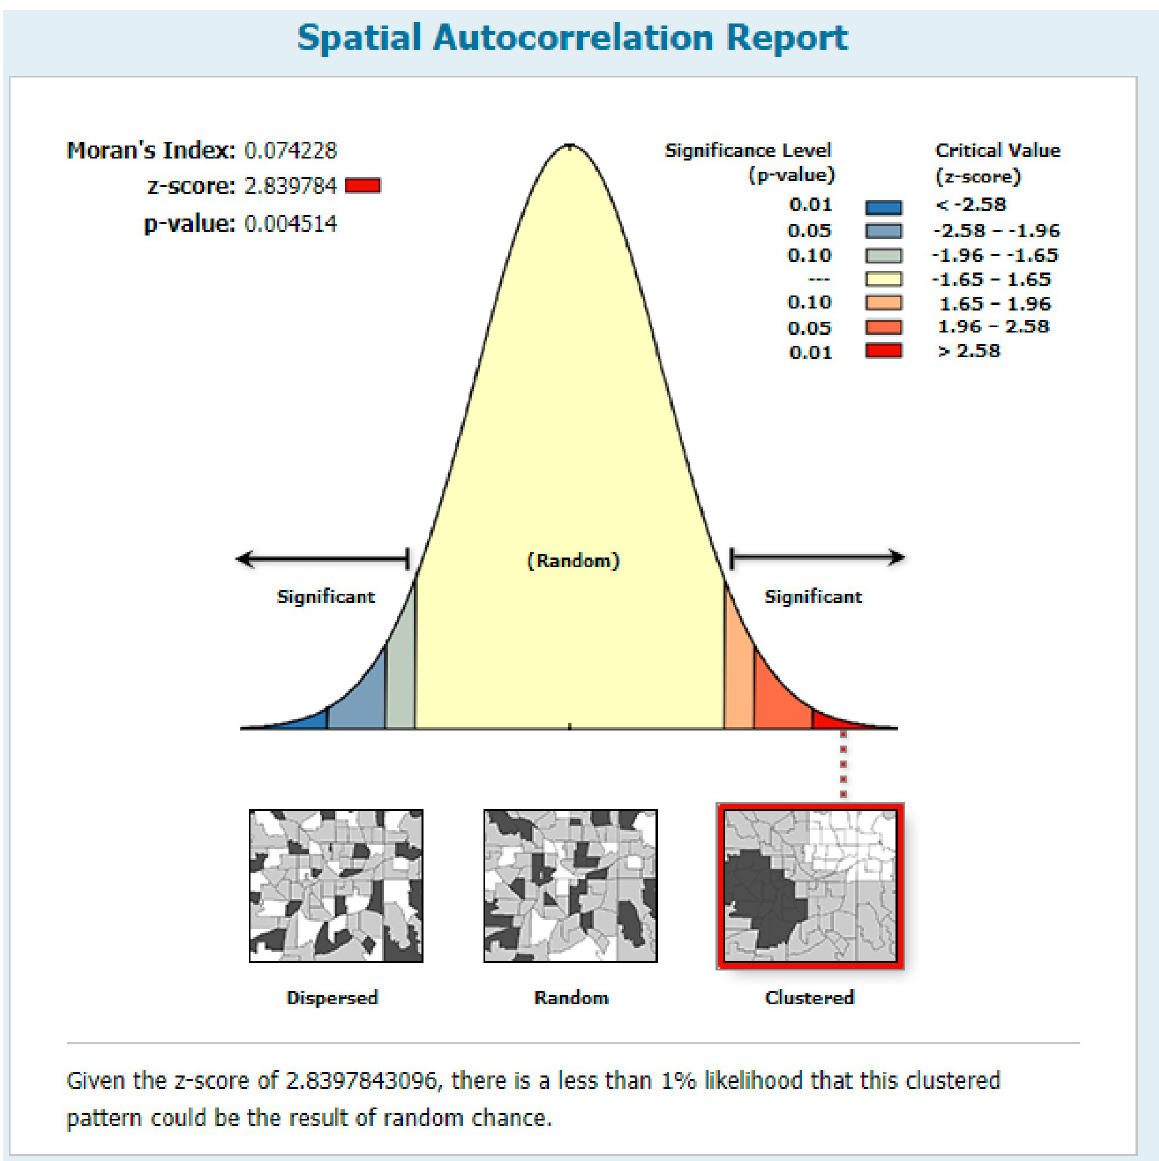
Fig 2. Spatial autocorrelation showing the clustering of MCV2 uptake, Map produced using Arc GIS version 10.7.